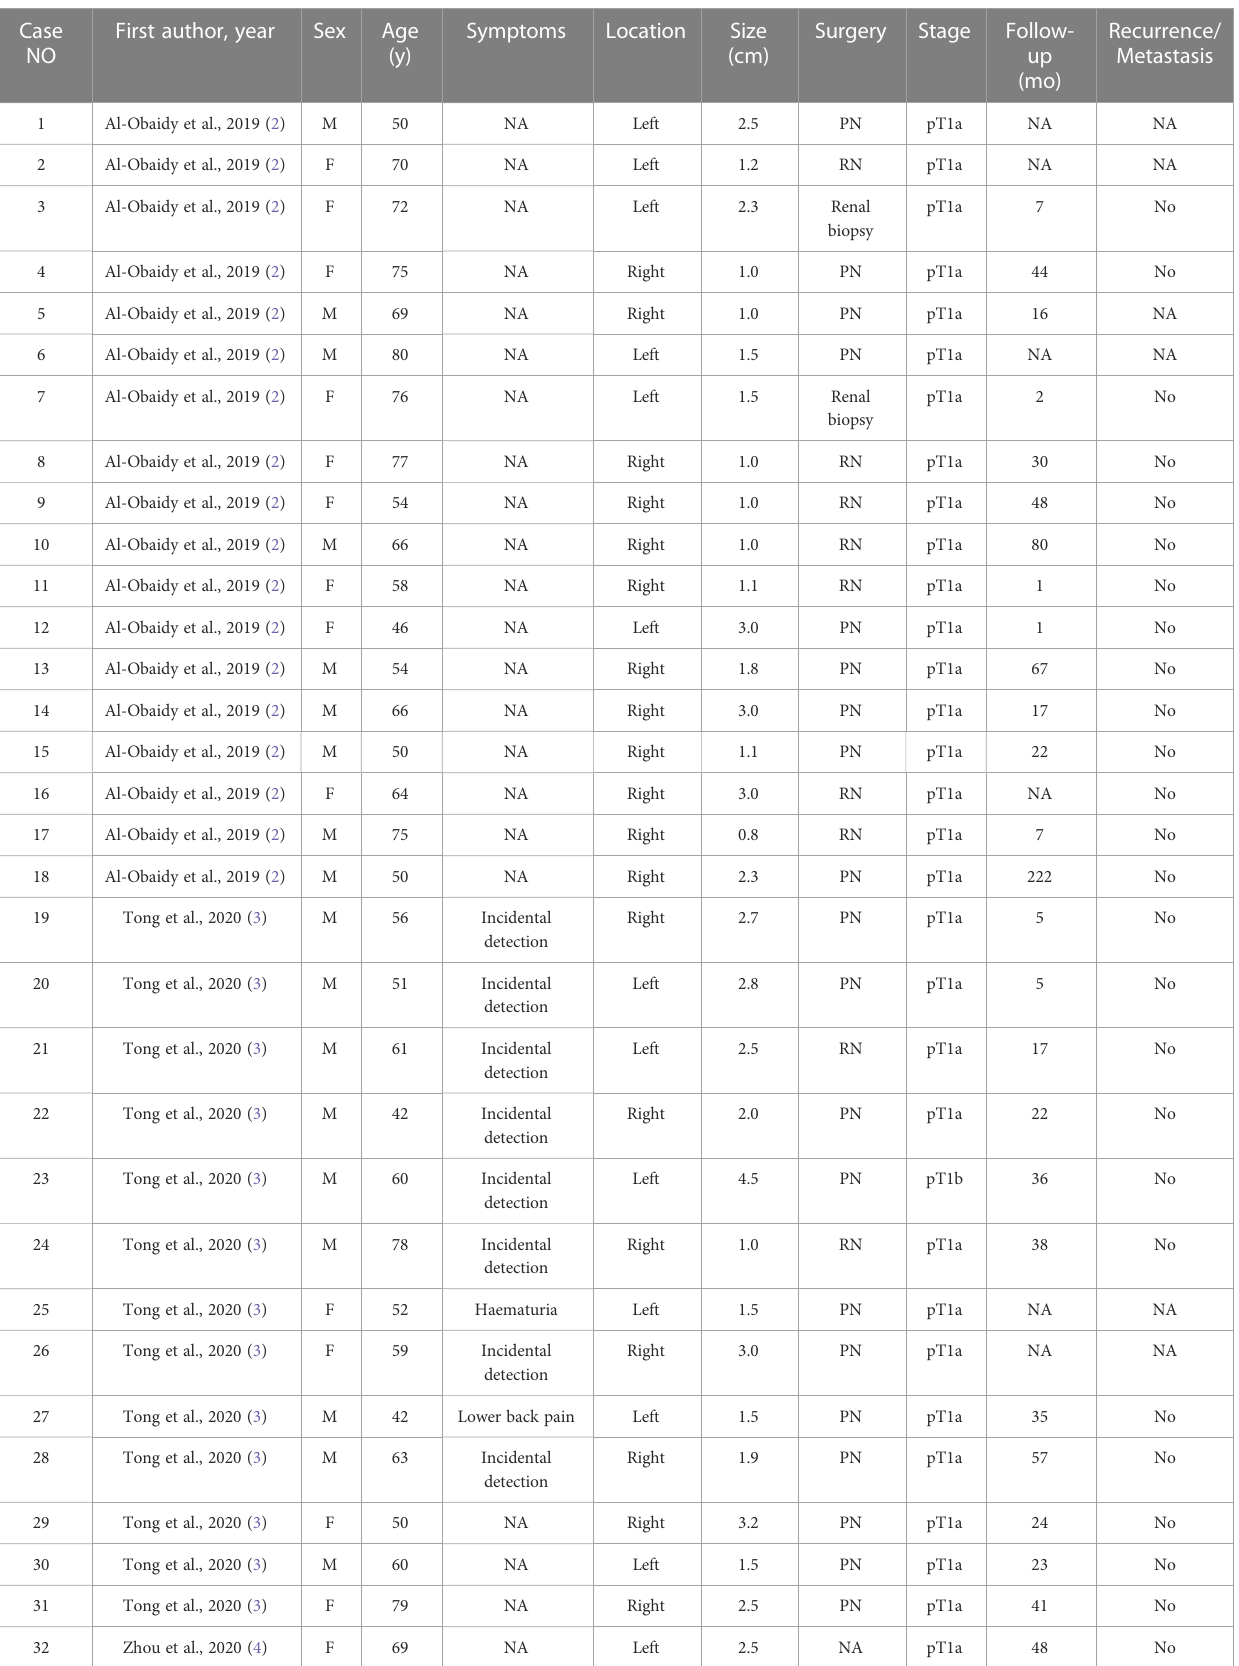
TABLE 1 Clinicopathologic Features of 97 Patients With PRNRP in the